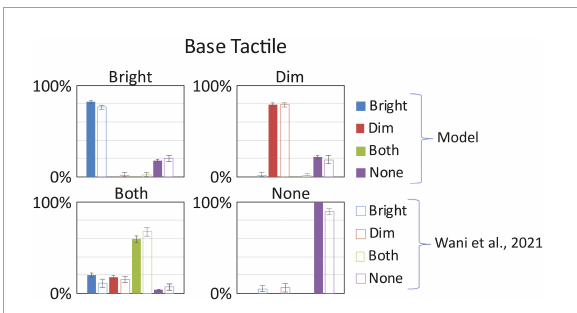
FIGURE3 Baseline tactile detection: model vs. (Wani et al., 2021) . In each box we reported the percent tactile responses ( y -axis), distributed across the four possible choices (Bright, Dim, Both, None, on the x -axis), mediated over the 20 simulated subjects, to a specific input configuration, specified in each box title: tactile stimulus only on the bright hand, “Bright,” on the dim hand, “Dim,” on both hands simultaneously, “Both,” and no stimulus, “None.” Errorbars indicate s.e.m. The responses obtained by the model, with its basal parameters’ values as in Supplementary Table 1 , are compared to the empirical results of Wani et al.